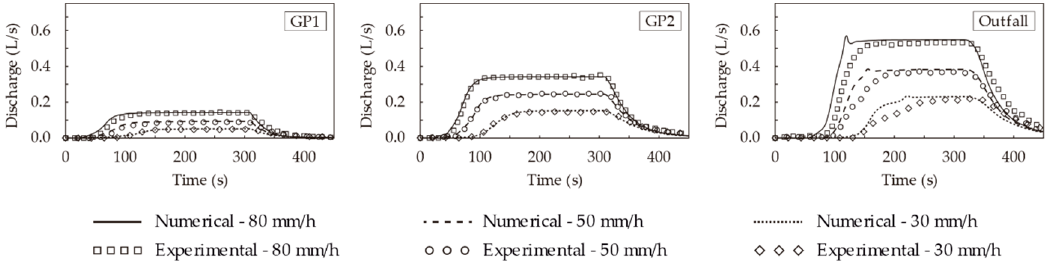
Figure 8. Experimental and numerical profiles of discharges at inlets GP1 ( left ) and GP2 ( middle ) and at the outfall ( right ).